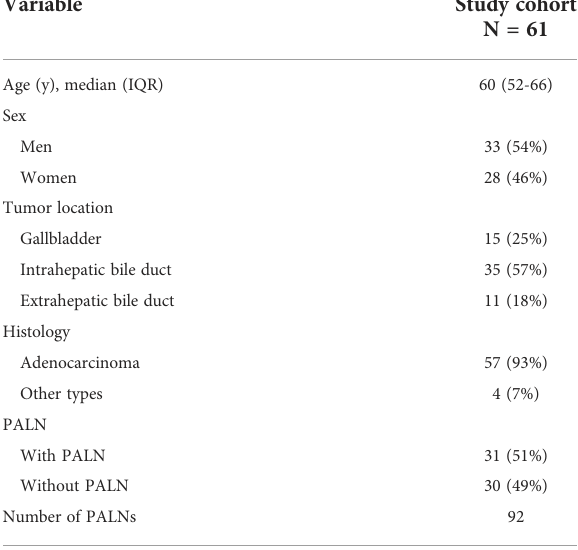
TABLE 1 Characteristics of patients in the study